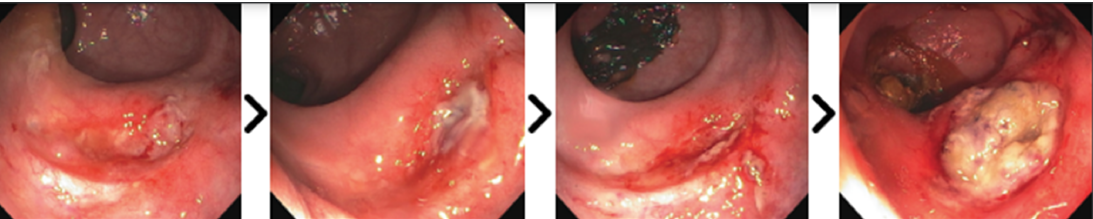
Figure 1. Interval endoscopies of a patient who refused treatment for RARC with disease progression. Over a period of one year, the tumor evolved from an ulcer along the anterior rectal wall.